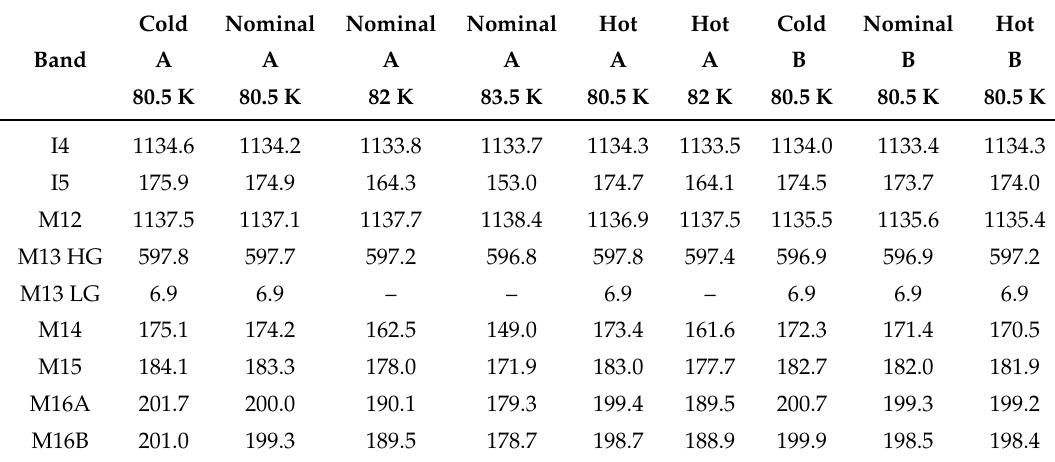
Table 3. Averaged gains (1/ c 1 ) over all detectors and HAM sides measured during radiometric performance testing for all instrument temperature plateaus, electronics sides (A or B), and focal plane temperatures using BCS